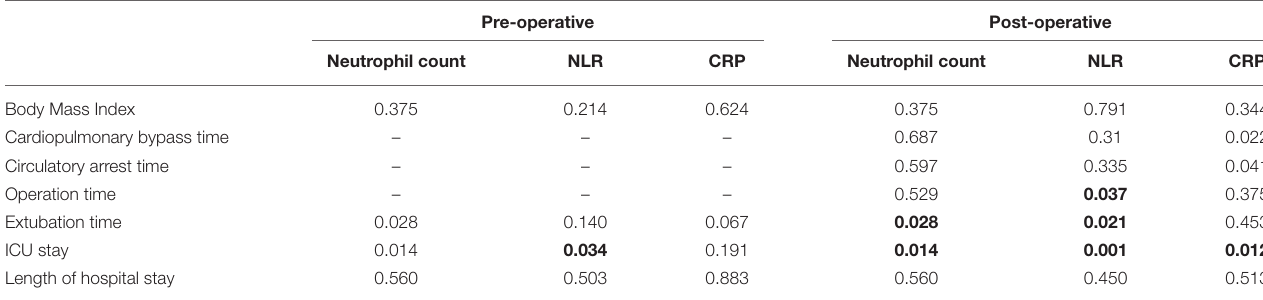
TABLE 2 | Spearman rank correlation coefficients of neutrophil count, NLR, and CRP levels measured before and after operation with clinical